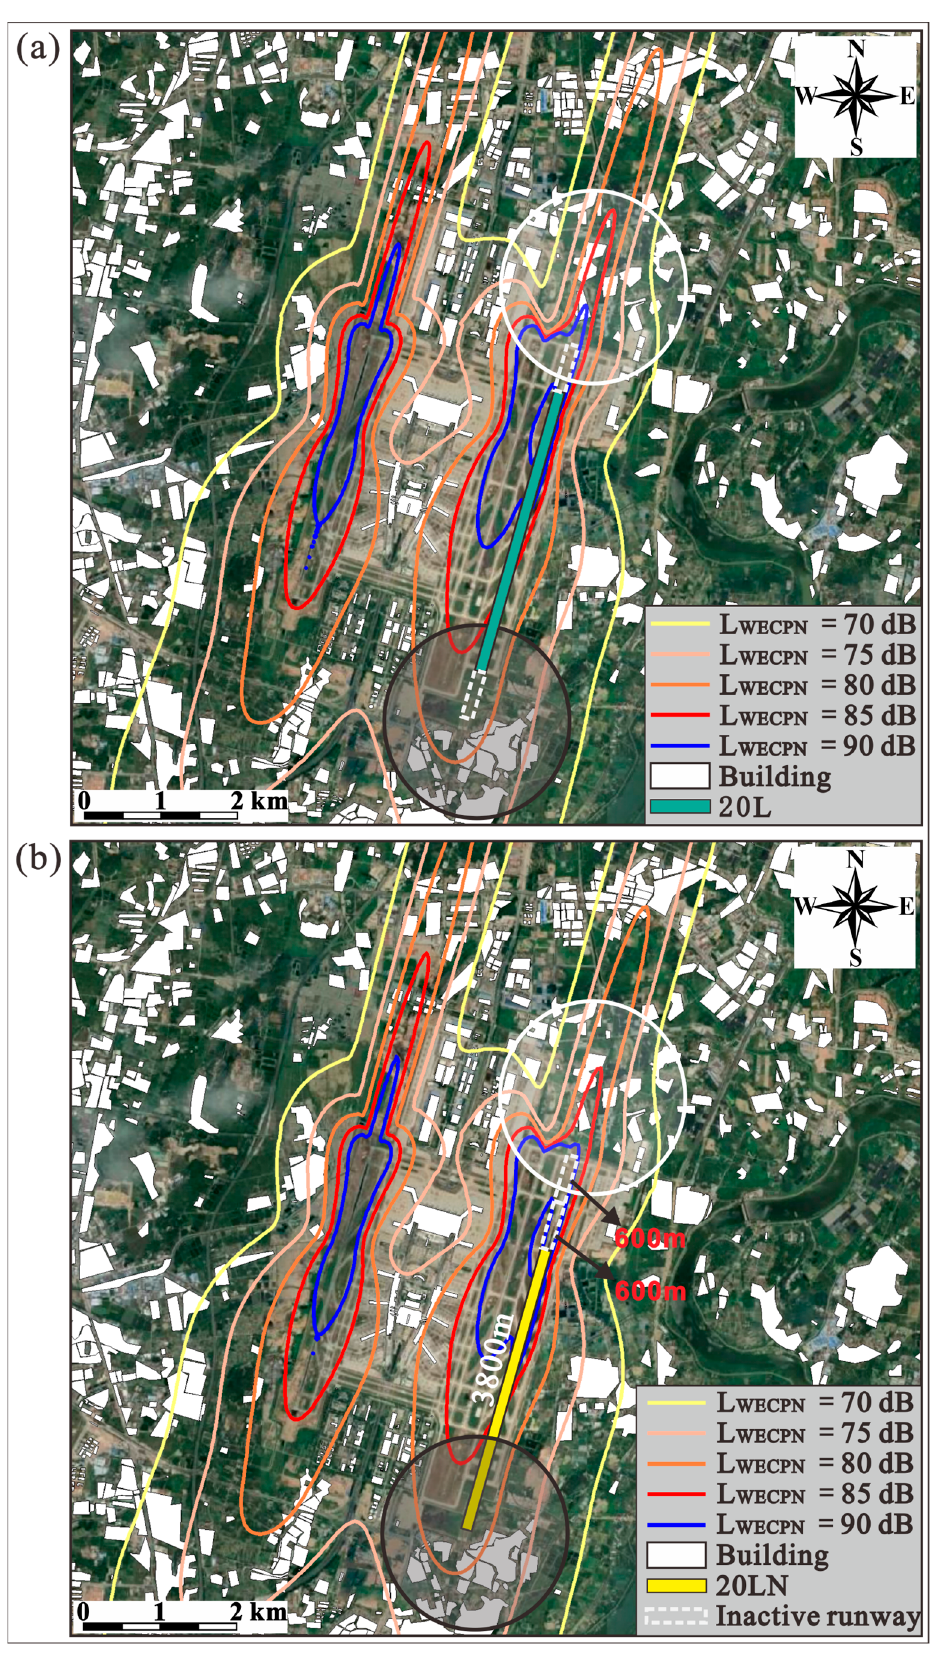
Figure 10. Noise contours ( a ) before and ( b ) after runway extension during summer.